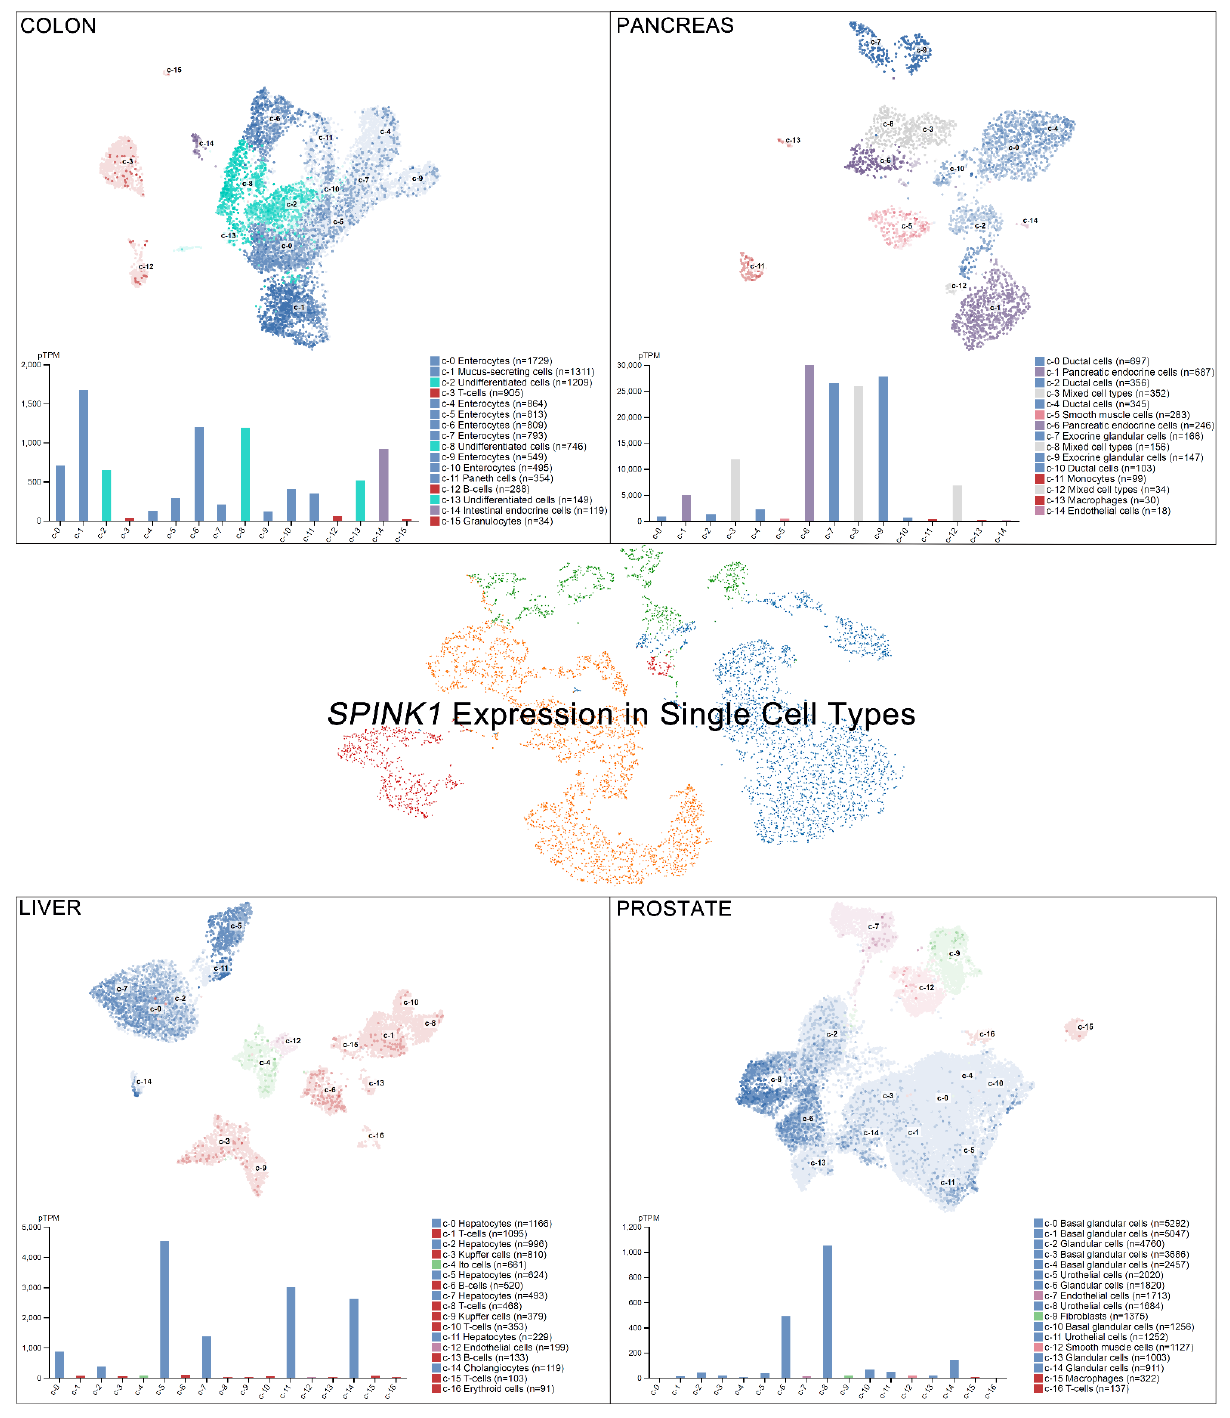
Figure 2. SPINK1 expression in single-cell types. The SPINK1 expression level was analyzed by single-cell RNA sequencing (scRNA-seq) using different human tissues (The Human Protein Atlas_ https://www.proteinatlas.org/, accessed on January 2021). RNA expression in the single-cell-type clusters identified in each tissue was visualized by a UMAP (Uniform Manifold Approximation and Projection) plot (top) and a bar chart (bottom). The read counts were normalized to transcripts per million protein-coding genes (pTPM) for each of the single-cell clusters.